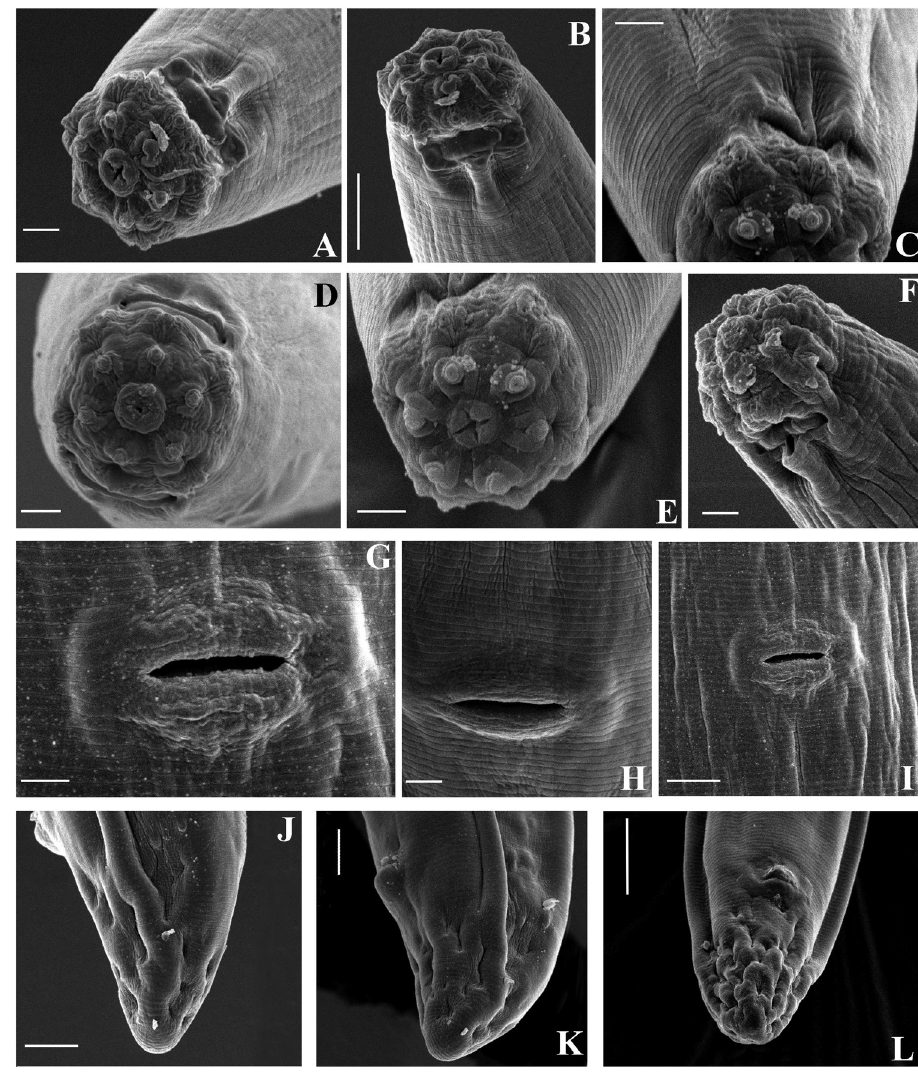
Figure 3. SEM micrographs. Enchodeloides signyensis (Loof, 1975), gen. n., comb. n. (= Enchodelus signy- ensis Loof, 1975). Female : A, D, E Lip region, in face view, amphid aperture B, F Lip region, in sublateral view C Cephalic and labial papillae G–I Vulval region J–L Tail ends. Scale bars: 2 µm ( A, C, D, E, F, G ); 5 µm ( B, I, J ); 10 µm ( L